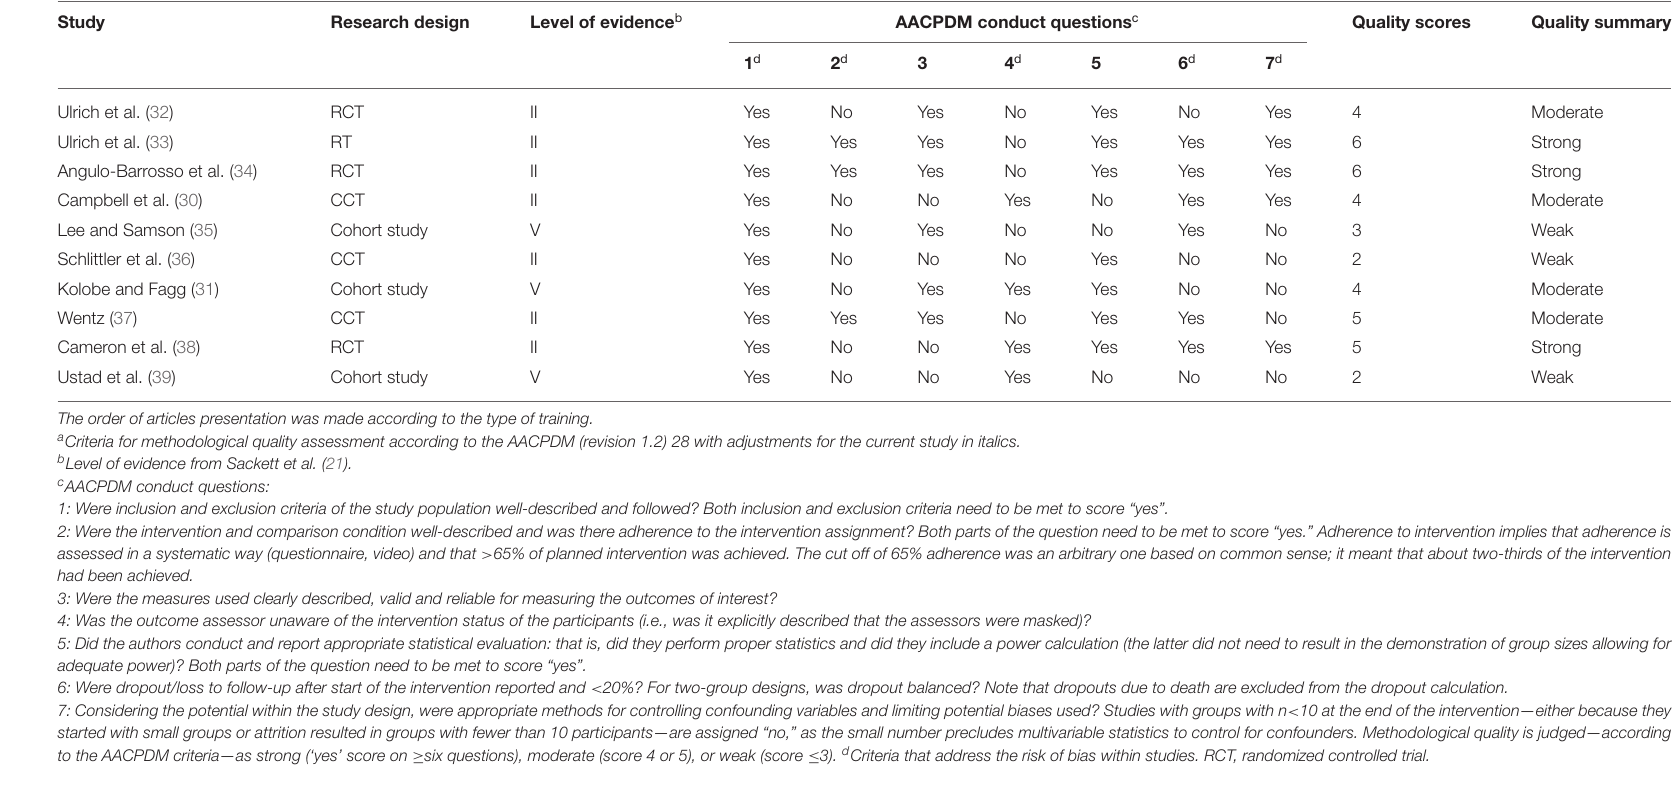
TABLE 1 | Studies included in the review, methodology assessment according to the American Academy for Cerebral Palsy and Developmental Medicine (AACPDM) a